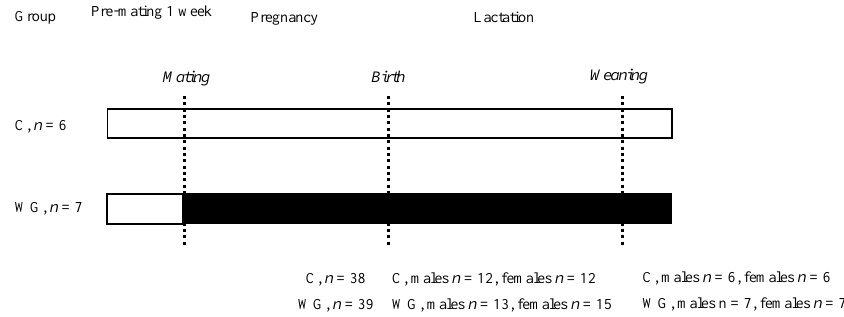
Figure 1. Study design. C, control diet; WG, wheat gluten diet. Values for n on the left show the number of successful pregnancies in each group and n at the bottom show the number of offspring that were used for